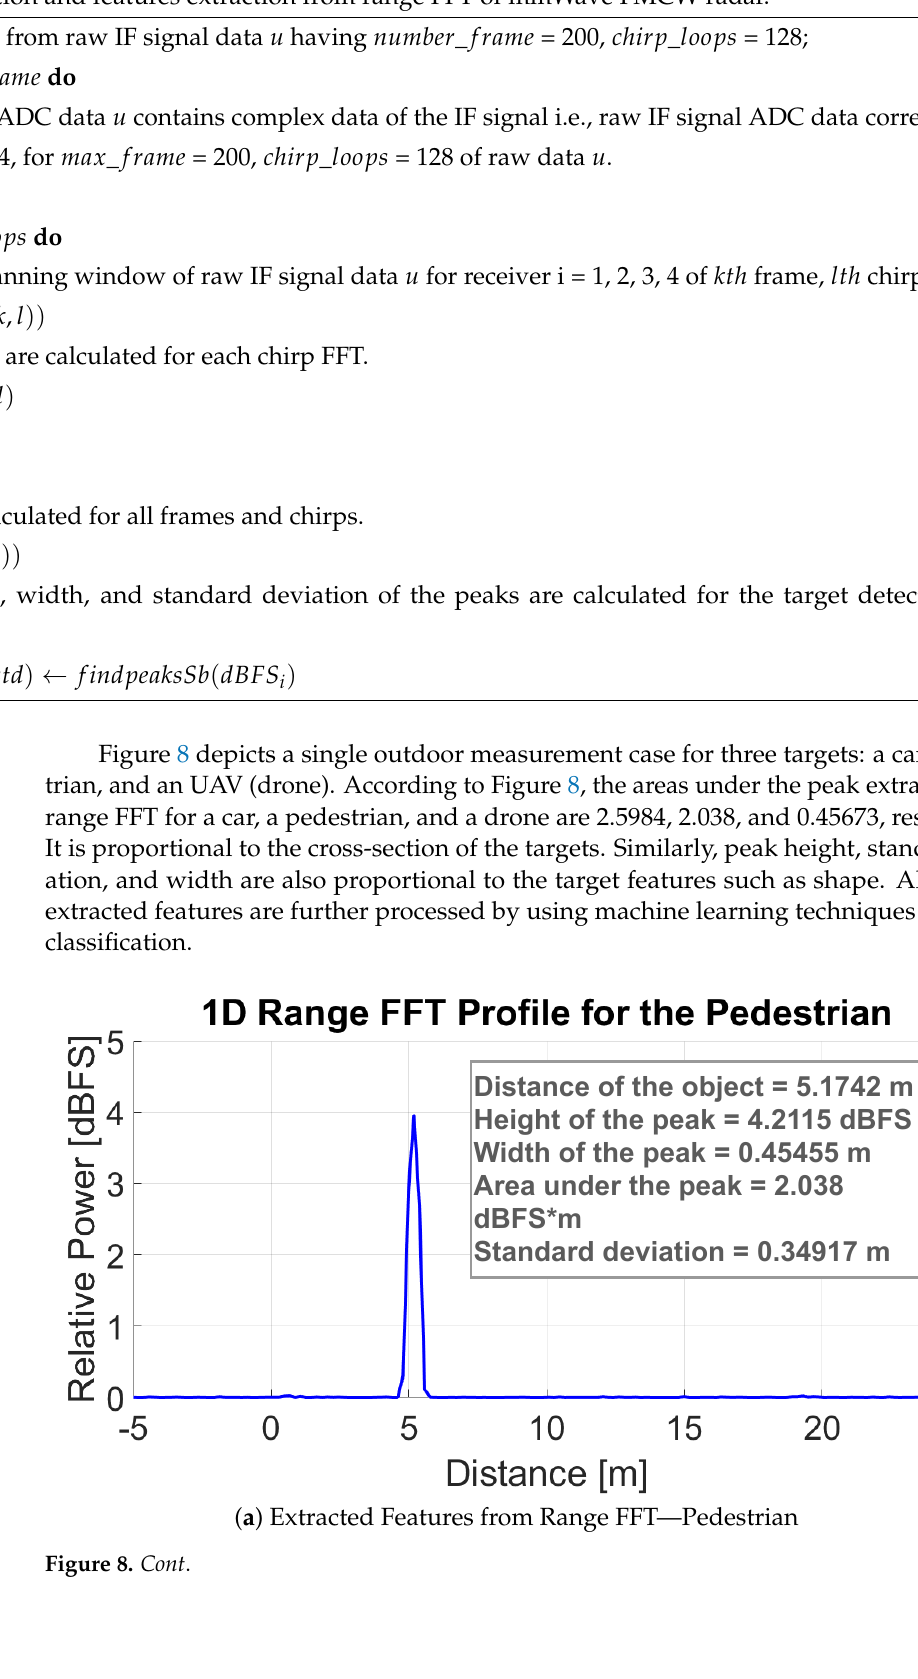
Algorithm 1 Object detection and features extraction from range FFT of mmWave FMCW radar.